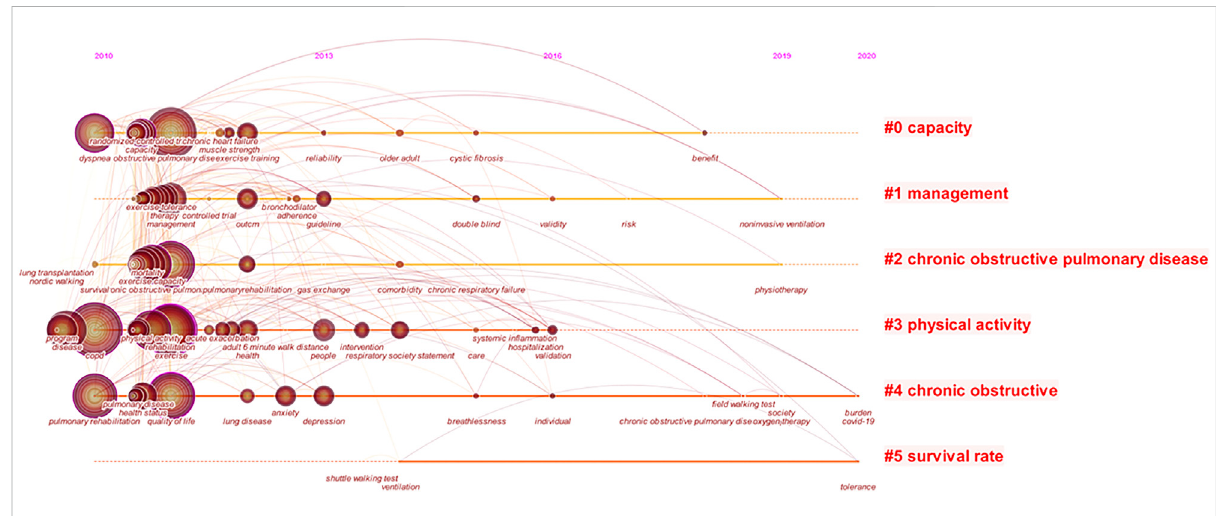
FIGURE 5 Evolutionary path in the studies of the COPD and Exercise Therapy. Figure 5 is used by Citespace.